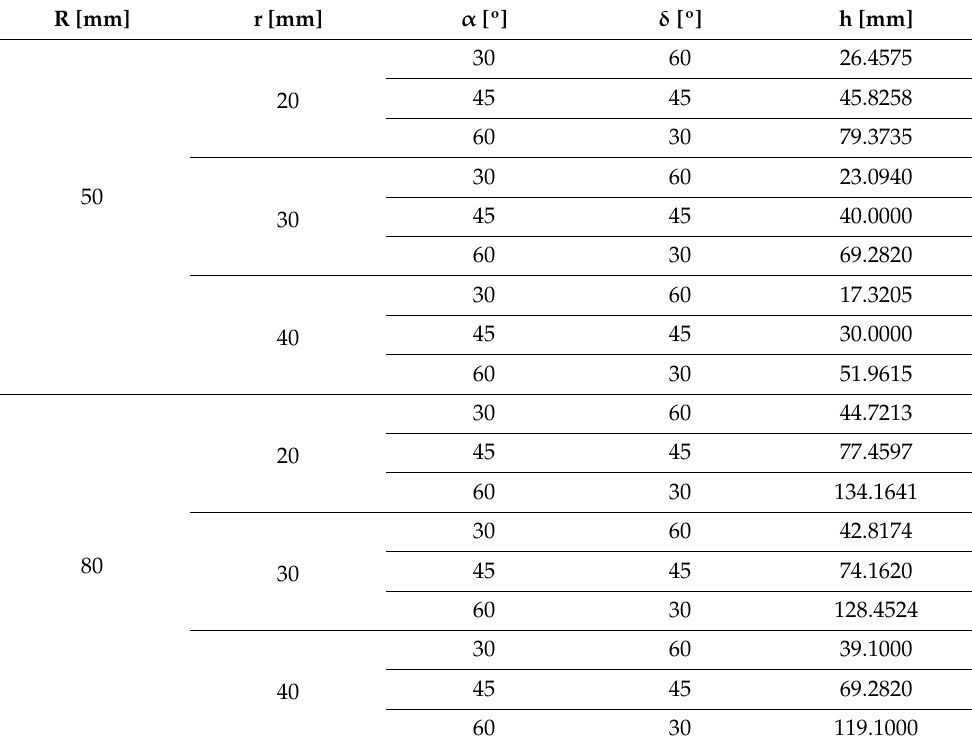
Table 1. Calculation of distance winding plane from guide-line depending on radius R of guide-line, frame radius r, and the required size of winding angle α